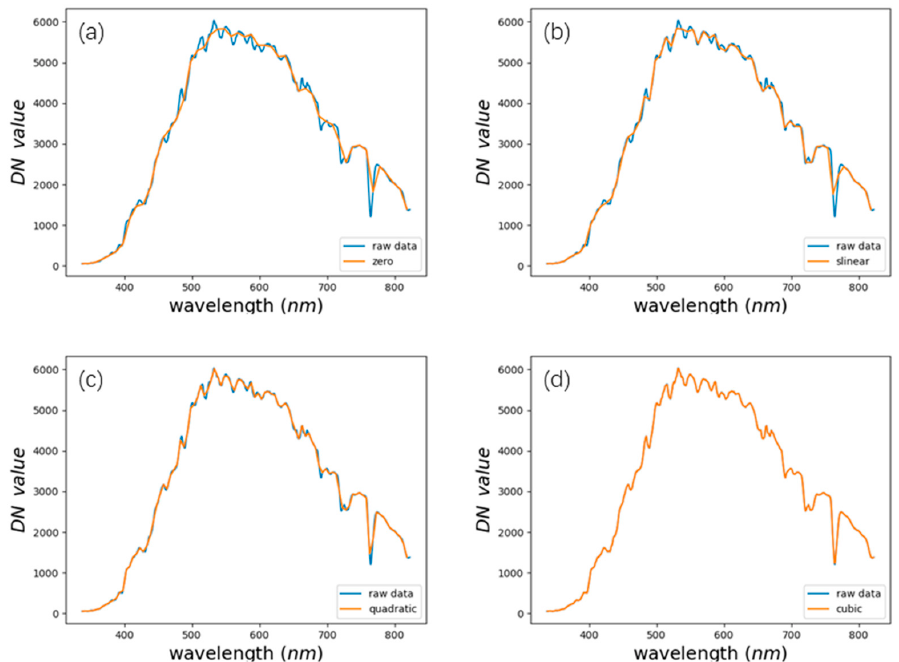
Figure A2. Comparison figure of different spectral resampling methods, ( a ) zero spline interpolation; ( b ) linear spline interpolation; ( c ) quadratic spline interpolation; ( d ) cubic spline interpolation.